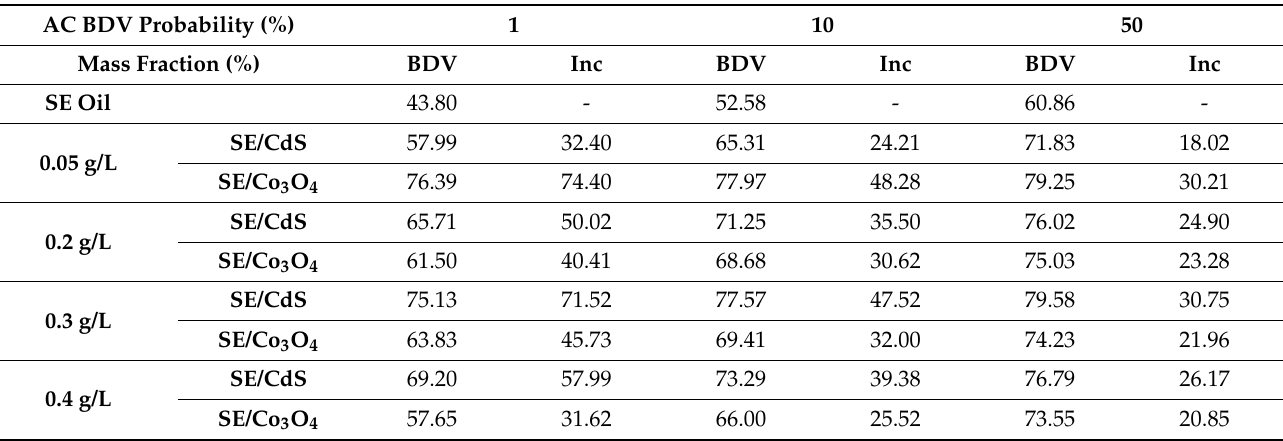
Table 4. Average AC breakdown voltage (kV) and increment (%) of different breakdown probabilities of various nanofluids and pure oil.